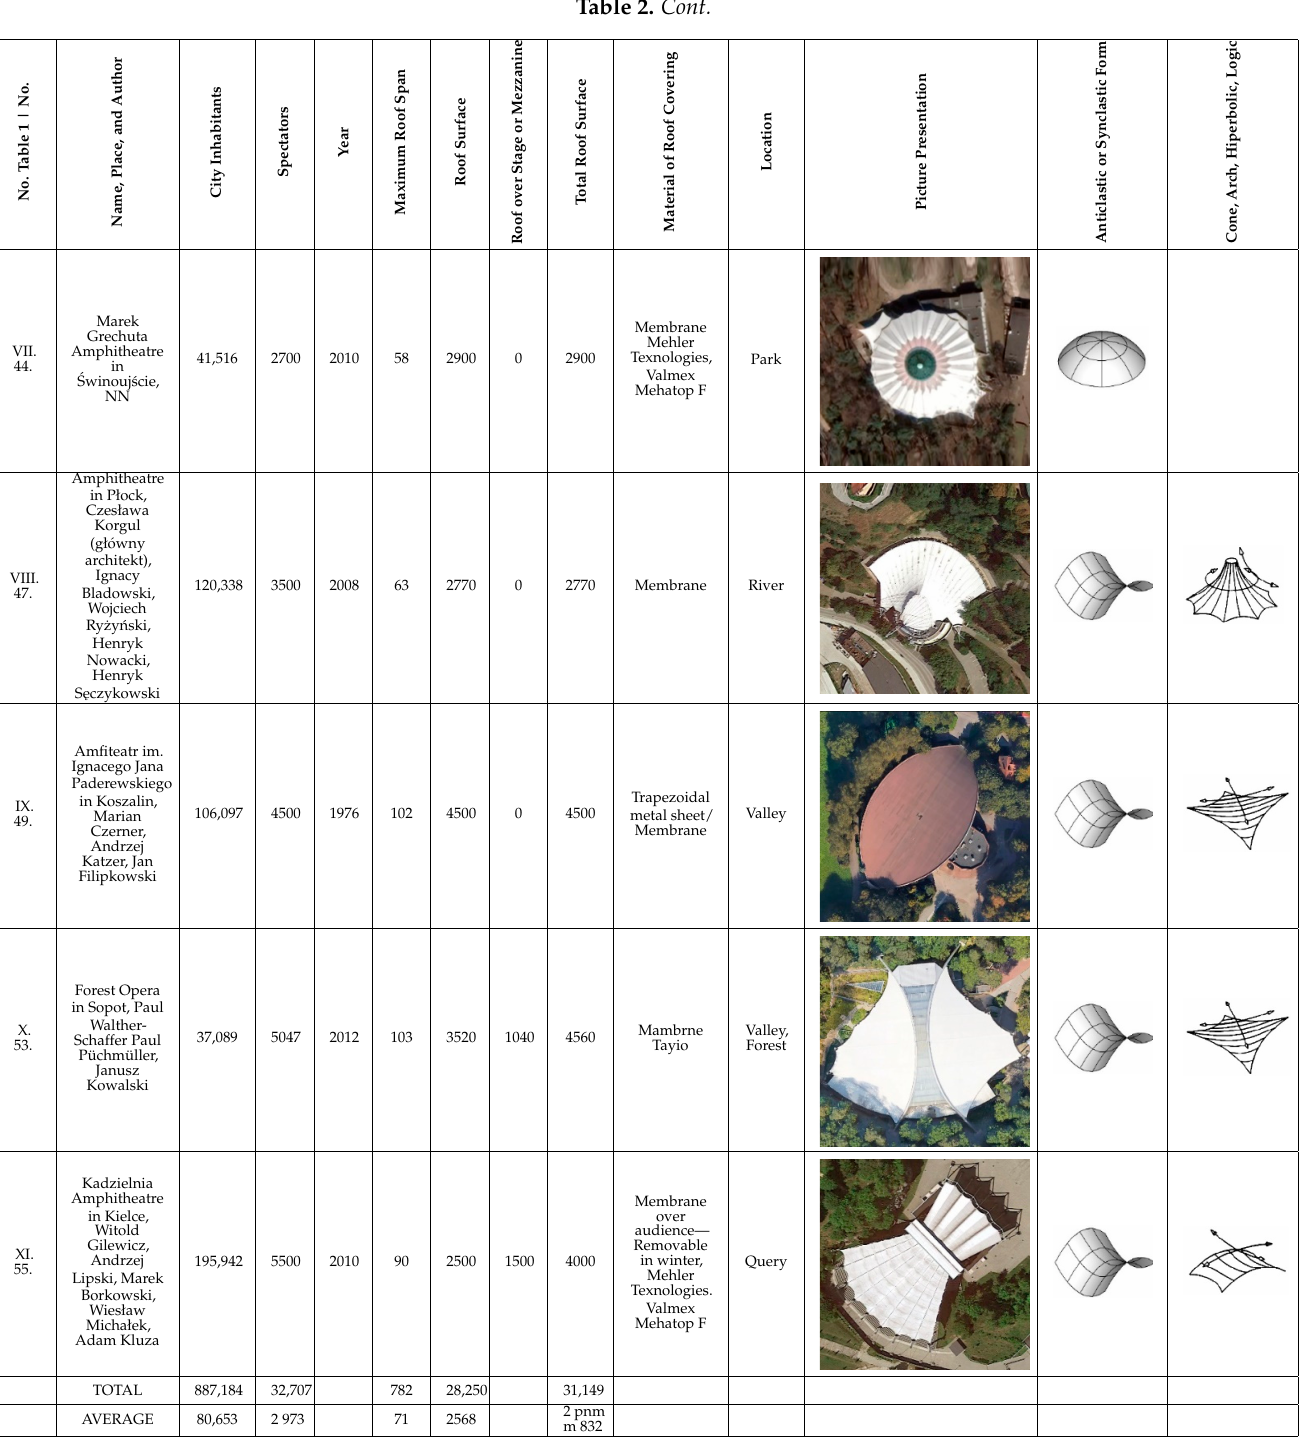
Membrane over audience—